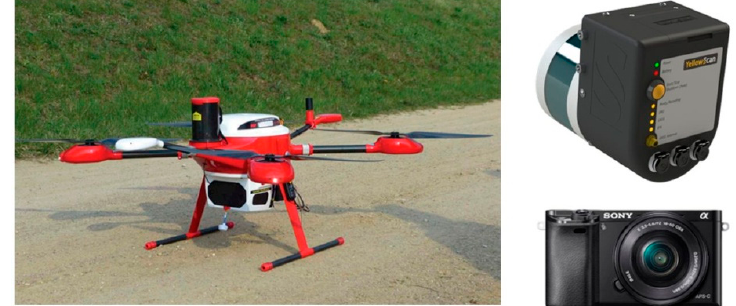
Figure 1. Platform Hawk Moth with its equipment: YellowScan Surveyor laser scanner and RGB camera Sony Alpha a6000.